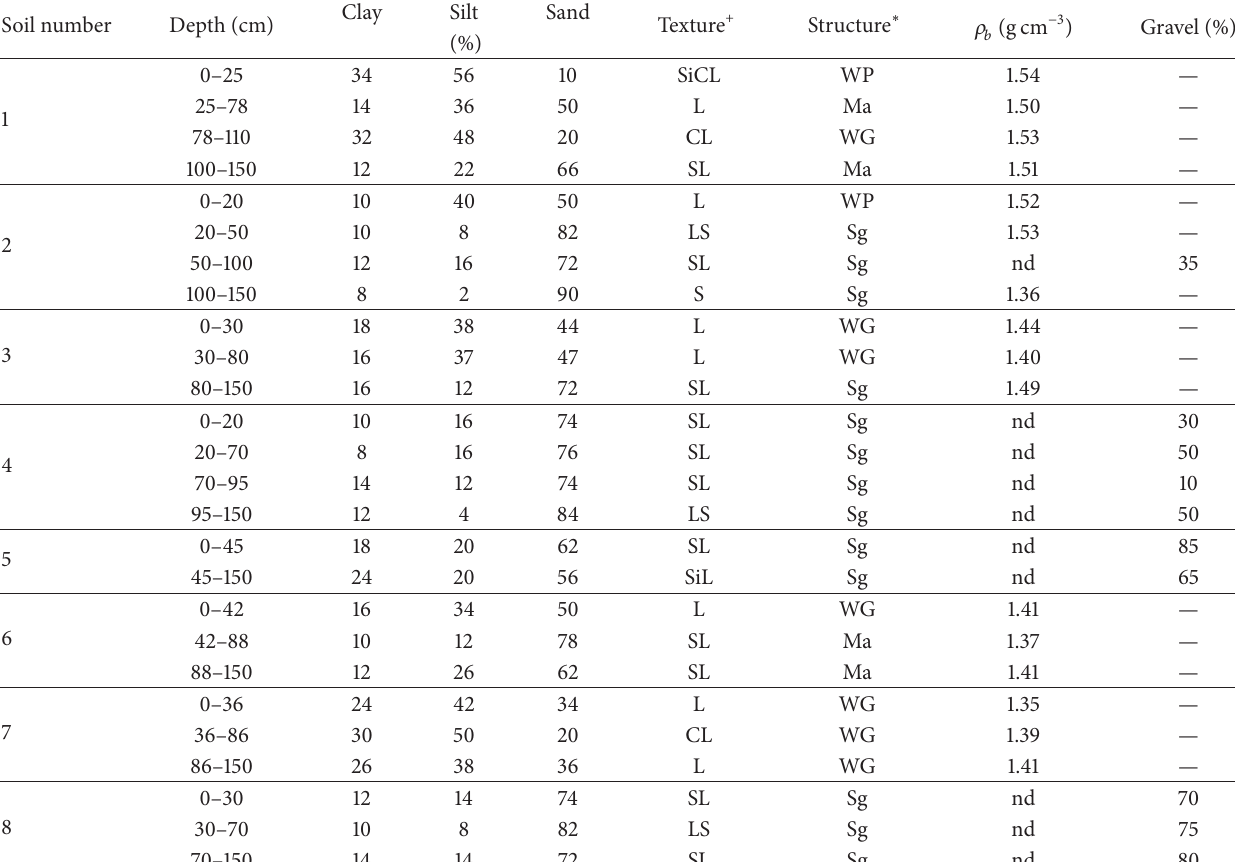
Table 2: Some physical properties of the representative